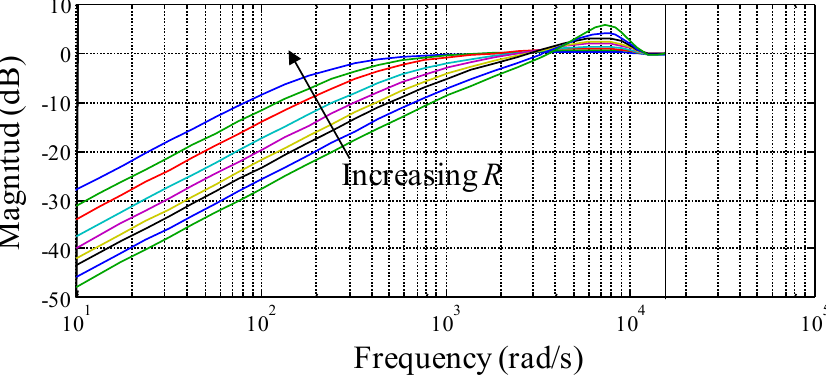
Figure 9. Bode magnitude diagram of S operating